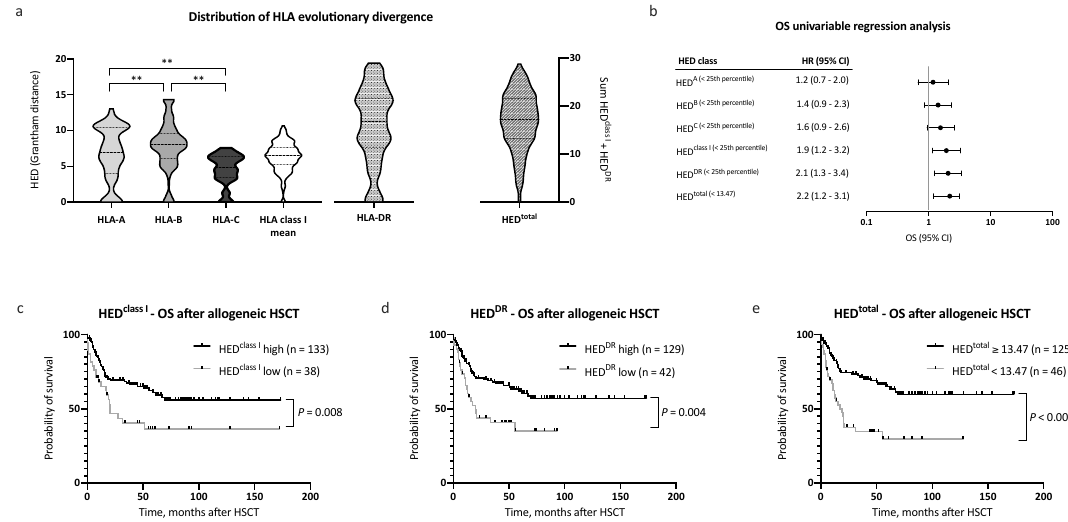
Figure 1. Distribution of human leukocyte antigen (HLA) evolutionary divergence and overall survival after allogeneic hematopoietic stem cell transplantation (HSCT). ( a ) Distribution of HLA evolutionary divergence (HED) with regard to HLA-A (25th percentile 3.99, median 6.89), HLA-B (25th percentile 6.11, median 8.05), HLA-C (25th percentile 3.39, median 4.82), HLA class I mean (25th percentile 5.23, median 6.50), and HLA-DR antigens (25th percentile 7.58, median 11.17), as well as the sum of HLA class I mean